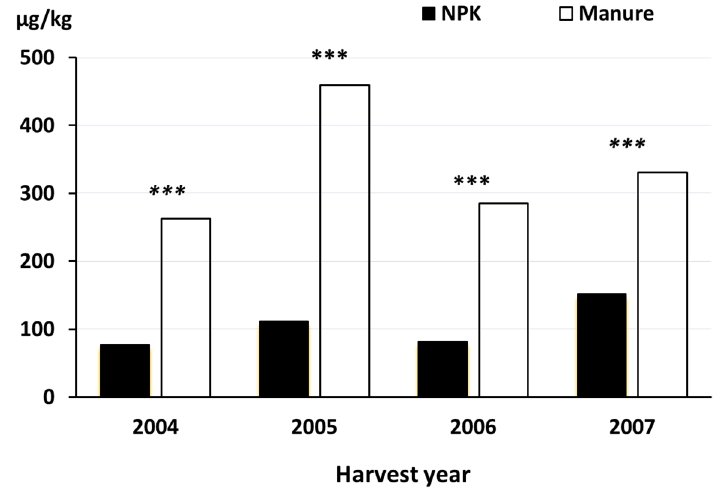
Figure 9. Effect of fertilization regimes (manure versus mineral NPK at the same total N-input level) on chlormequat residues in wheat grain produced in NFSC trial plots managed with conventional, pesticide-based crop protection. Data from [58]. ***, significant difference ( p < 0.001). The maximum residue level (MRL) set by the EU for chlormequat residues in wheat grain is 7 mg/kg.